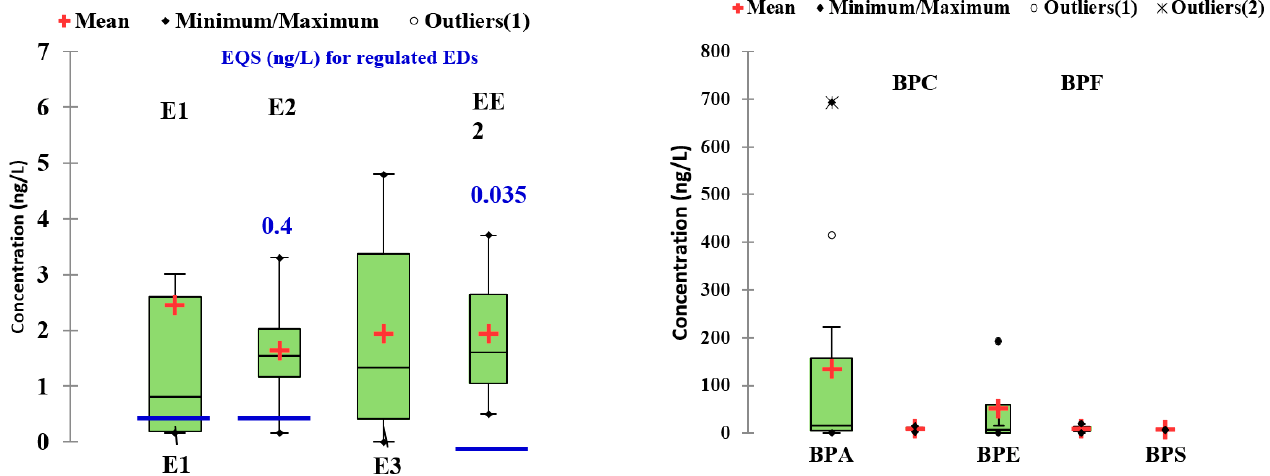
Figure 3. Variation of common EDs ( left ) and BPs ( right ) in surface waters of the Lower Danube basin. Proposed maximum acceptable concentration (MAC-EQS) for estrogen hormones according to the Decisions 2020/1161/EU are highlighted.